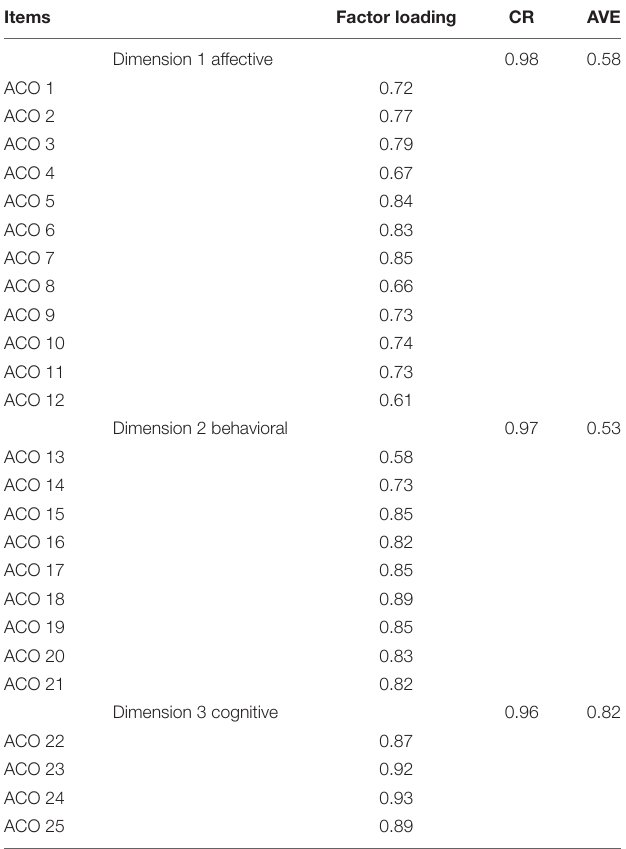
TABLE 2 | Results of the CFA with factor loadings, composite reliability, and average variance extracted from ACO for nursing students. Items